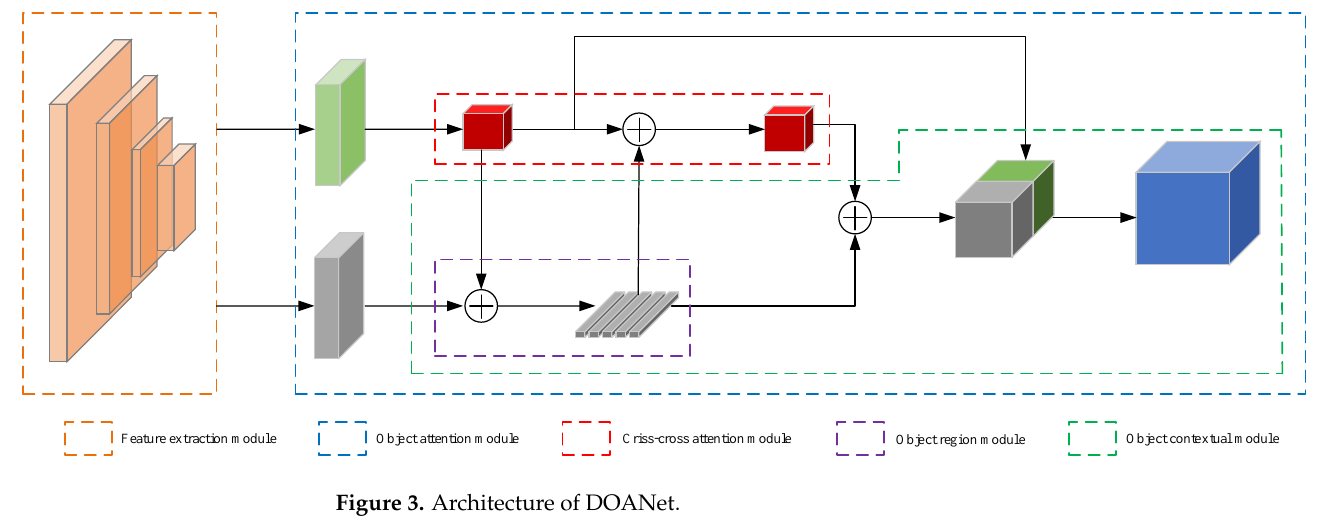
Figure 3. Architecture of DOANet.